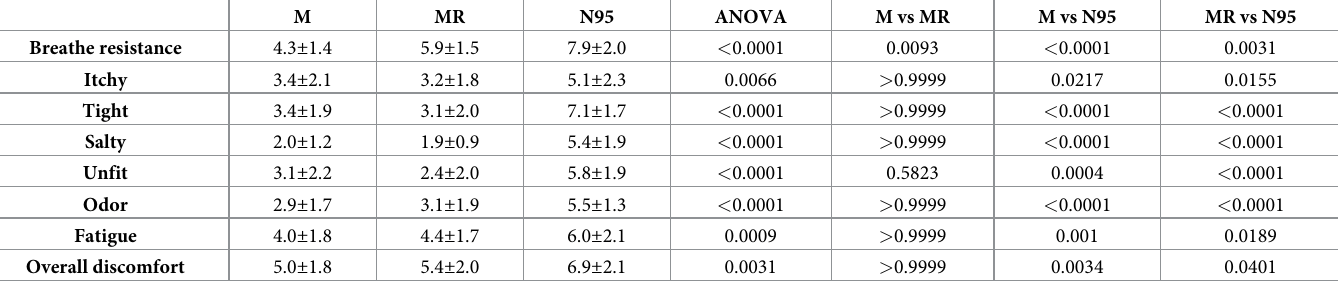
Table 3. Subjective perceived